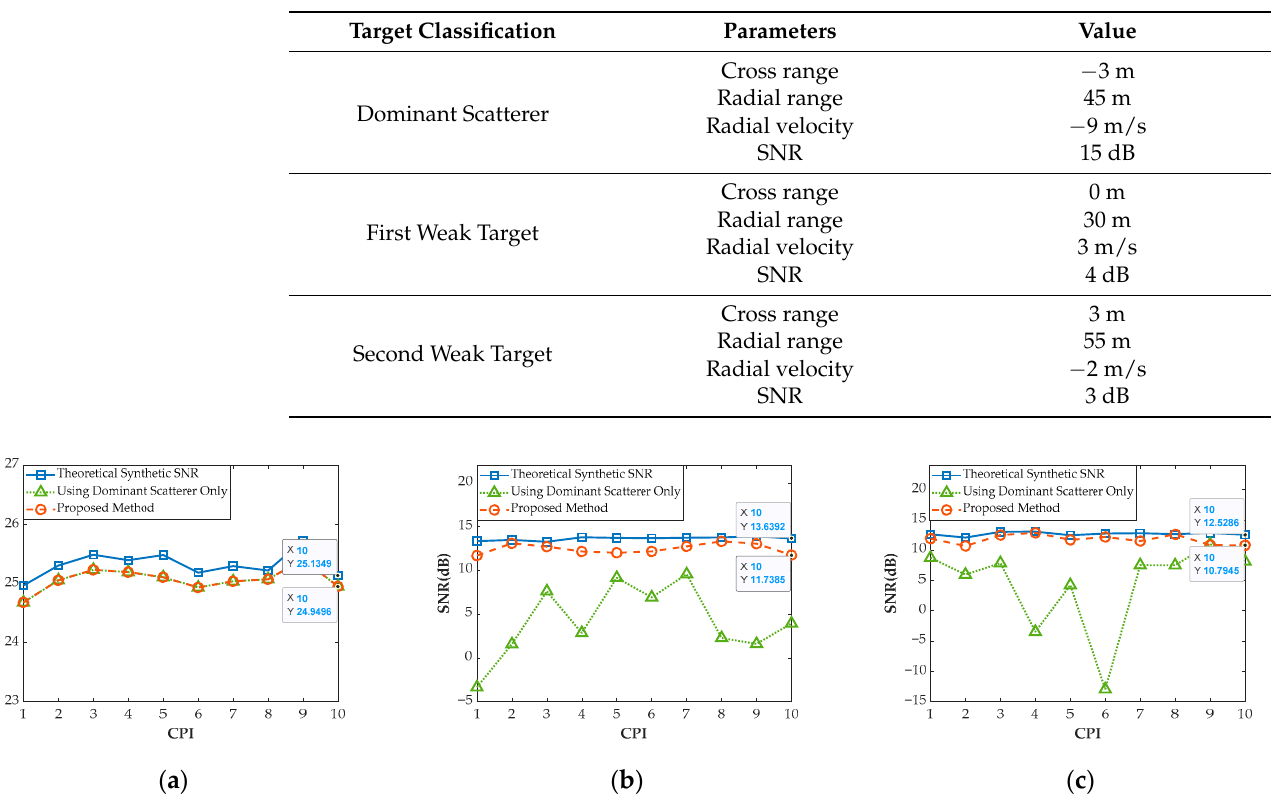
Table 4. Parameters of multiple targets.